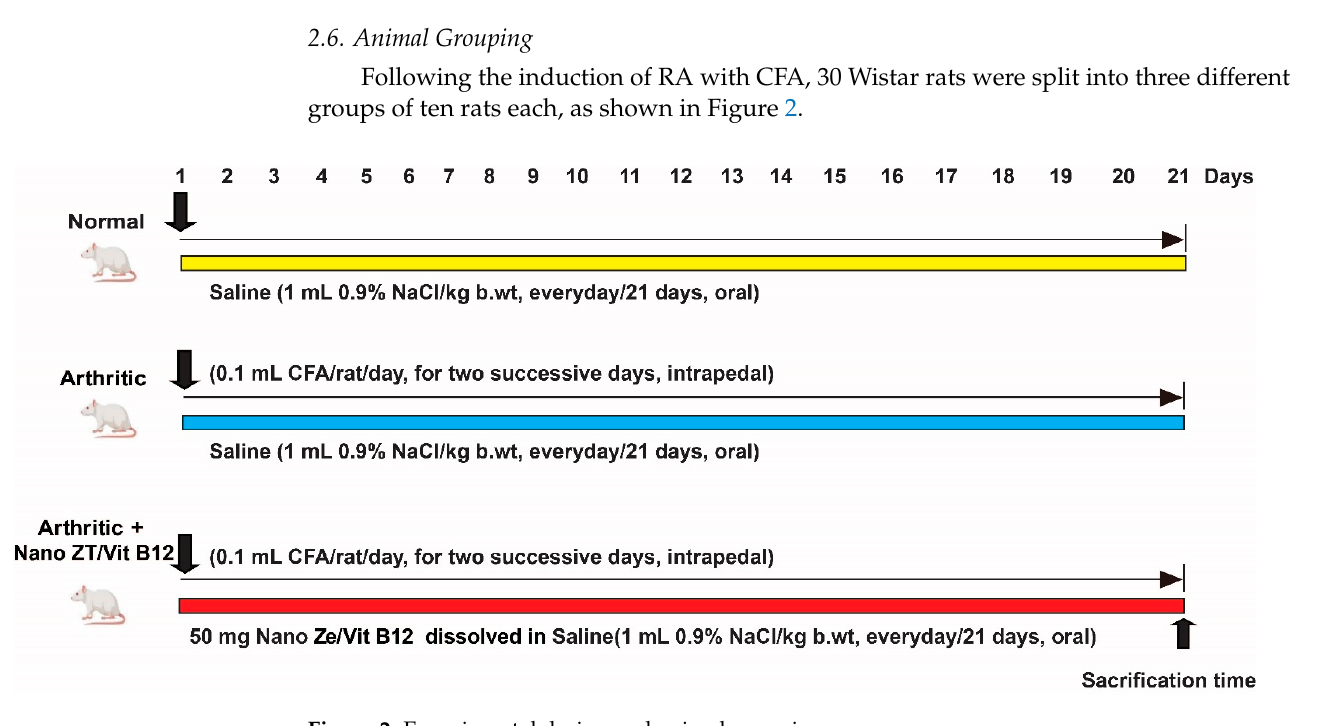
Figure 2. Experimental design and animal grouping.